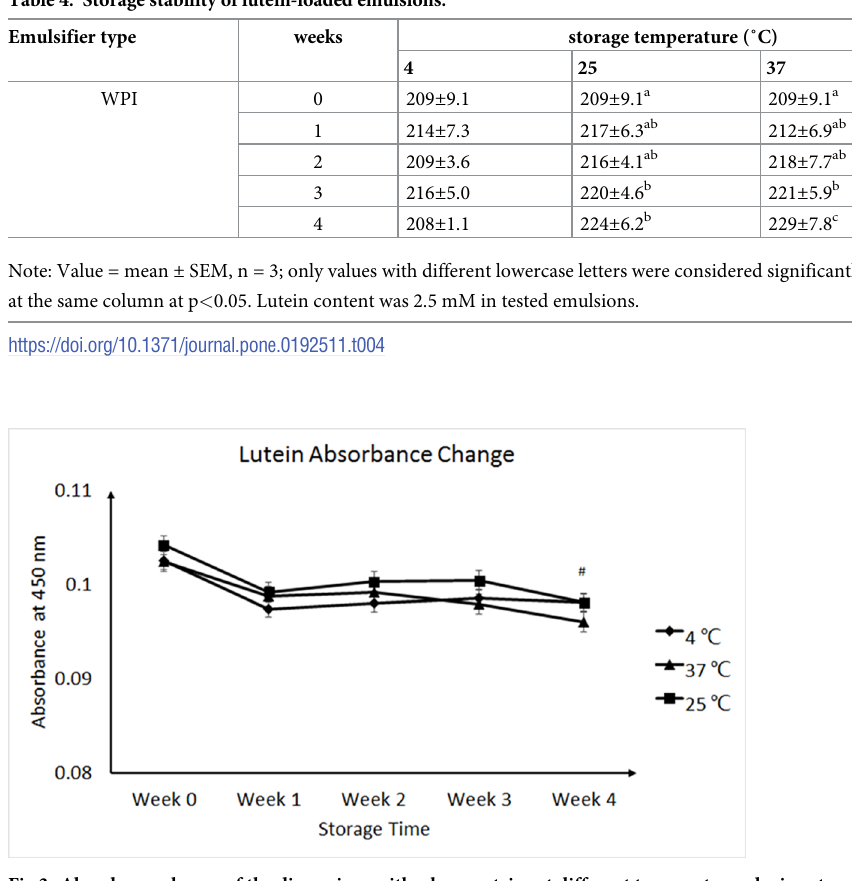
Fig 3. Absorbance change of the dispersions with whey proteins at different temperatures during storage. Absorbance change of the dispersions with whey proteins at temperatures of 4˚C, 25˚C and 37˚C were recorded weekly during storage. # Significantly different compared with the values at week 0 (p < 0.05). No significant change was observed by temperature, though the dispersion showed lower absorbance at 37˚C. Value = mean ± SEM, n =